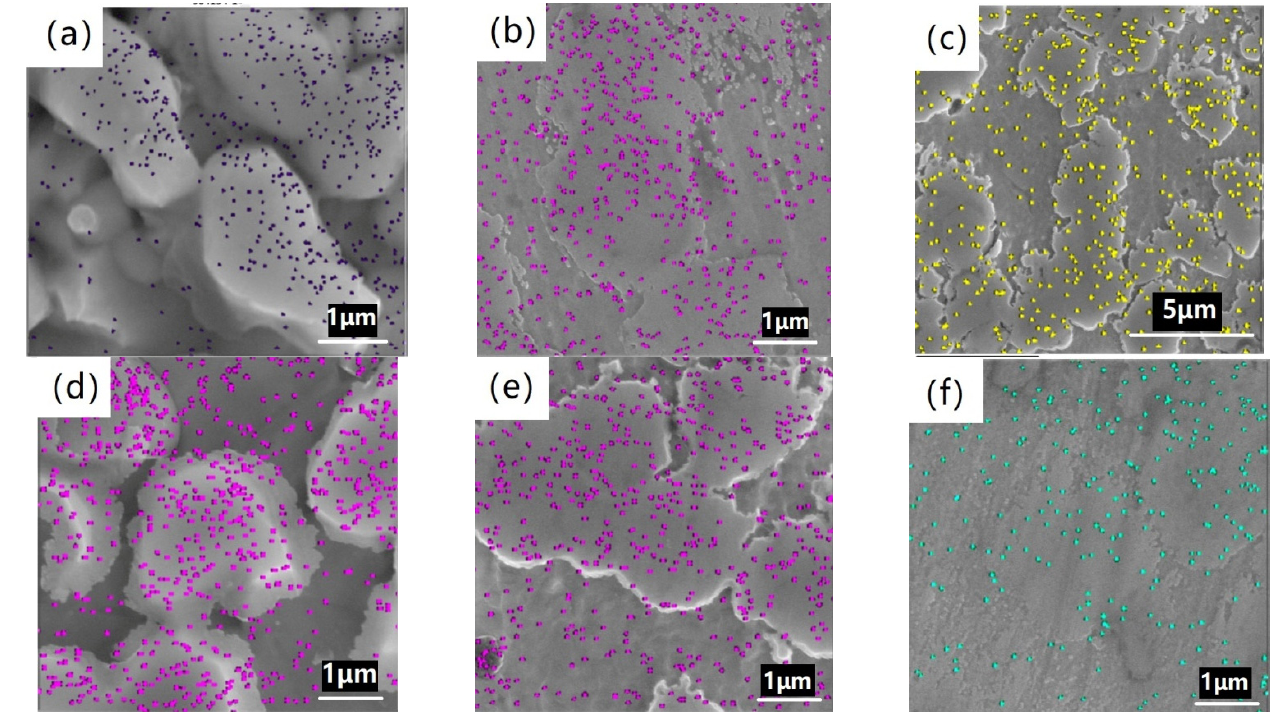
Figure 4. SEM-EDS plane analysis of boron after heat treatment at (a) 900 °C, (b) 1000 °C, (c) 1050 °C, (d) 1100 °C, (e) 1150 °C and (f) 1200 °C.